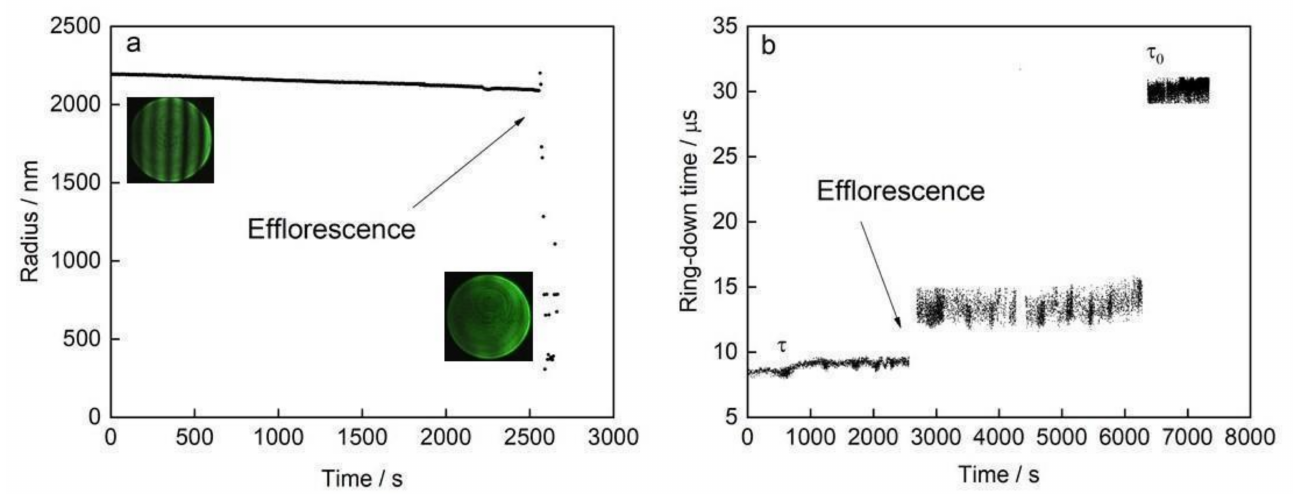
Figure 2. Evaporation of a (NH 4 ) 2 SO 4 droplet, shown by change in ( a ) radius, and ( b ) simultaneous ring-down time measurements even after